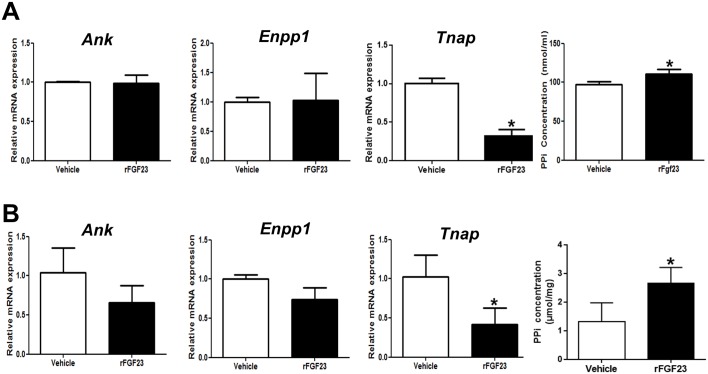
rFGF23 administration suppresses Tnap mRNA expression and increases PPi concentration in WT osteocyte-like cells and bones of WT mice.
(A) mRNA abundance of Ank, Enpp1, and Tnap as well as PPi concentration in cell culture supernatant in WT calvarial osteocyte-like cells differentiated for 22 d, and subsequently treated with rFGF23 for 24 h. (B) mRNA abundance of Ank, Enpp1, and Tnap in total RNA isolated from whole femurs and PPi concentration in extracts of whole tibiae from 3-mo-old male WT mice treated with rFGF23 or vehicle for 5 d. Each data point is the mean ± SD of at least four experimental samples in A, and of at least five mice in B. Individual values are given in S1 Data. *, p < 0.05 versus vehicle.